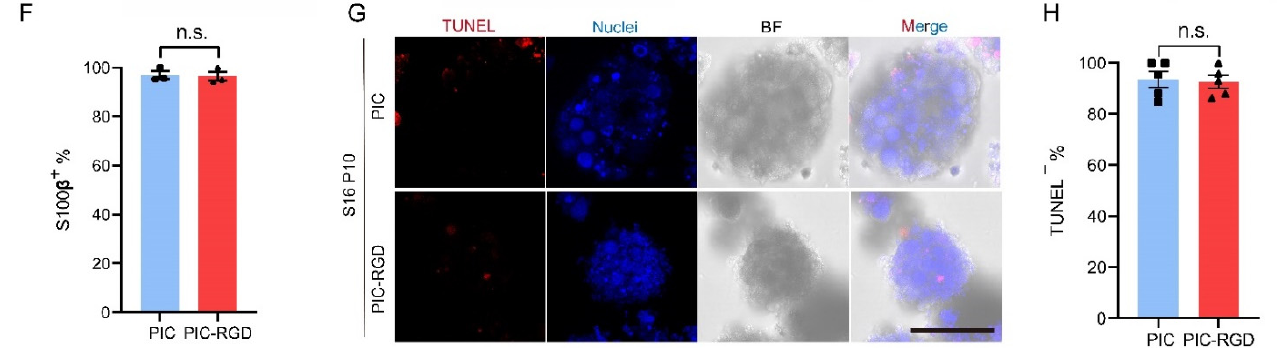
Figure 2. Characterization of rat Schwann cell (S16) in PIC hydrogels. ( A ) S16 cells were encapsulated in PIC and PIC-RGD and went through 7 days of culture (scale bar =100 µ m). ( B ) The maximum projected area of cell spheroids under one field of vision on day 7. S16 shows larger spheroids formation in PIC than in PIC-RGD (* p < 0.05). ( C ) Number of S16 grown in PIC and PIC-RGD for 0, 3, and 7 days. The error bars represent the standard error of the mean of three experiments. ( D ) The growth characteristic of amplified cells is stable after 10 rounds of passaging in PIC and PIC-RGD. Note that S16 were subcultured always in the same type of matrices, either PIC or PIC-RGD (scale bar =100 µ m). ( E ) Fluorescence staining of P10 S16 spheroids after 7 days in culture in PIC and PIC-RGD shows good maintenance of cellular characteristics. S100 β : in red, Schwann cells maker; phalloidin: in green, stains F-actin and Hoechst 33342: in blue, stains cell nuclei (scale bar =100 µ m). ( F ) Percentage of S100 β positive cells per field of vision. ( G )TUNEL assay (red) with Hoechst 33342 staining (blue, cell nuclei) and bright field image of P10 S16 after 7 days in culture in PIC and PIC-RGD show few apoptotic cells in spheroids (scale bar =100 µ m). ( H ) Percentage of TUNEL negative cells per field of vision. For all samples, the PIC and PIC-RGD concentration c =1 mg mL − 1 , and the initial cell density is 200,000 cells mL − 1 . (n.s. means no significant differences).